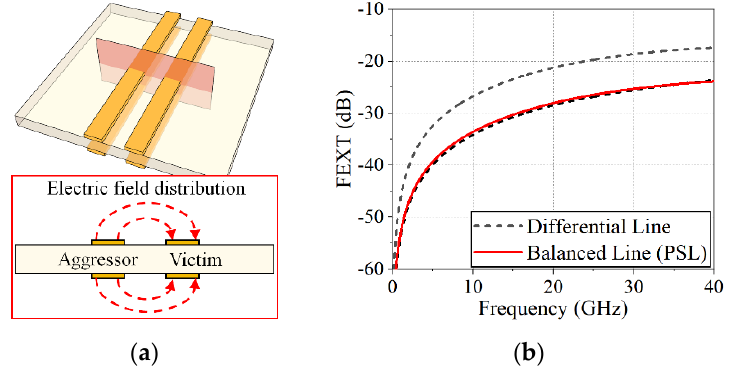
Figure 6. ( a ) Crosstalk level between the PSL pairs, ( b ) crosstalk levels due to adjacent lines (DL pair: linewidth of 10 mil, gap width of 10 mil, distance of 30 mil with a 5 mil FR–4 substrate, PSL pair: width of 10 mil, distance of 30 mil with a 5 mil FR–4 substrate).